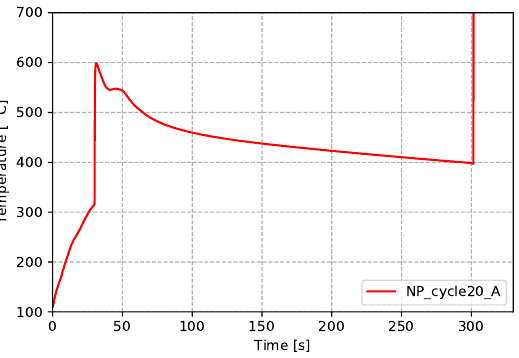
Figure 11. Temperatures measured from cast-in TCs (in wheel)—non-production process